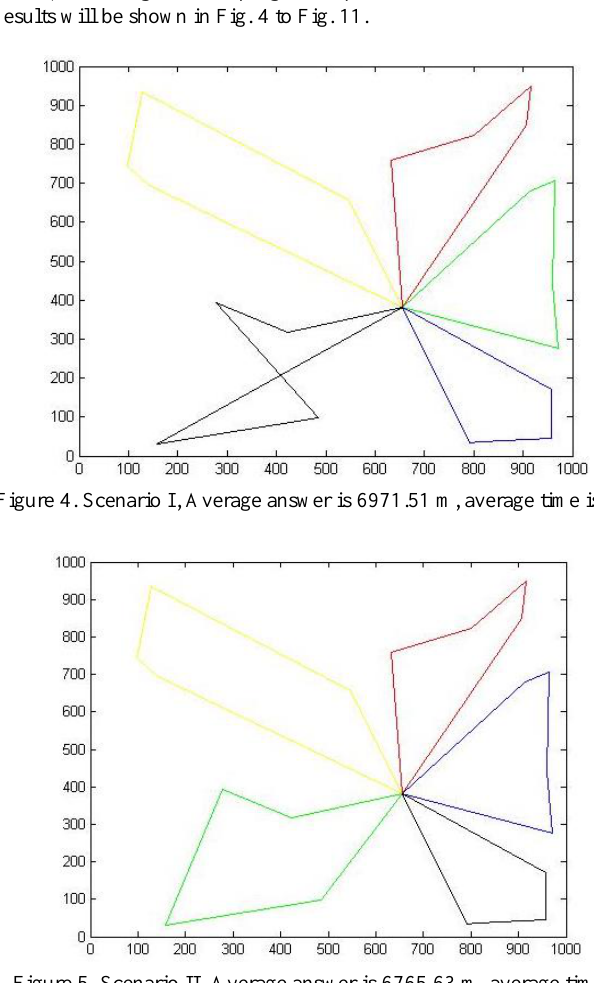
Figure 5. Scenario II, Average answer is 6765.63 m, average time is